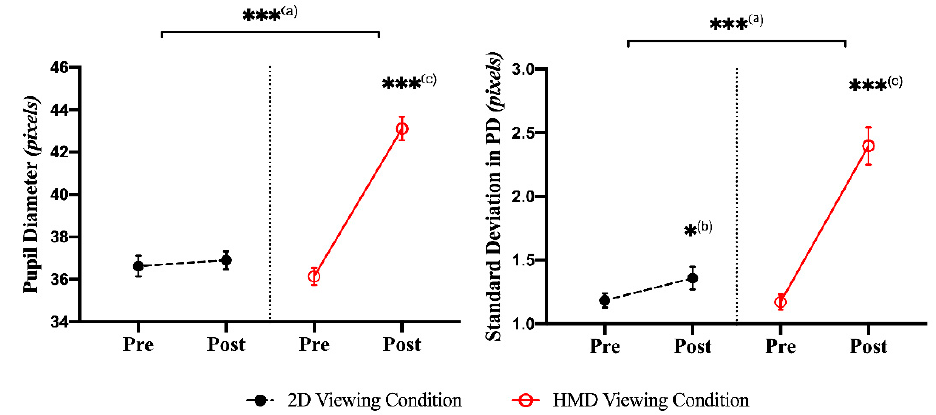
Figure 5. Representation of the mPD and sPD for motion sickness between the 2D and HMD conditions. There was a significant difference based on a paired t -test and ANCOVA (* p < 0.05; *** p < 0.001). ( a ) The ANCOVA test between the 2D and HMD viewing condition. ( b ) A paired t -test between pre- and post-viewing in the 2D condition. ( c ) A paired t -test between pre- and post-viewing in the HMD